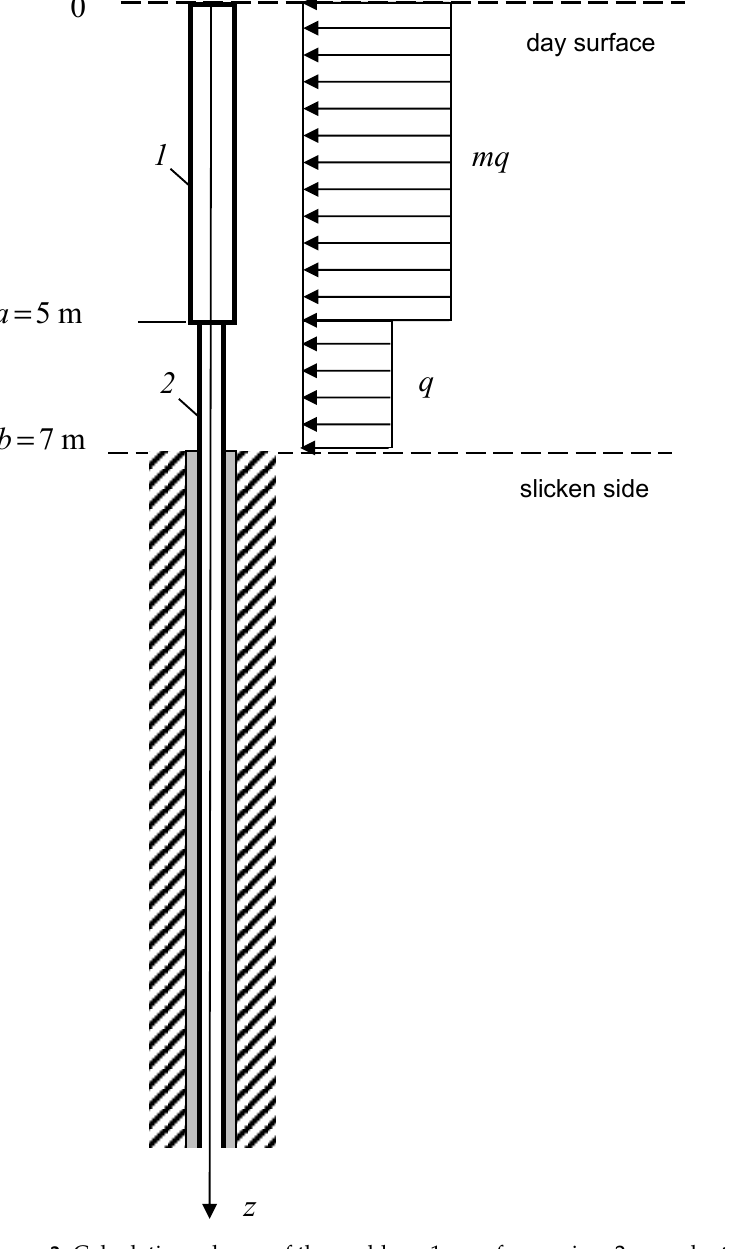
Figure 3. Calculation scheme of the problem: 1—surface casing, 2—conductor casing.